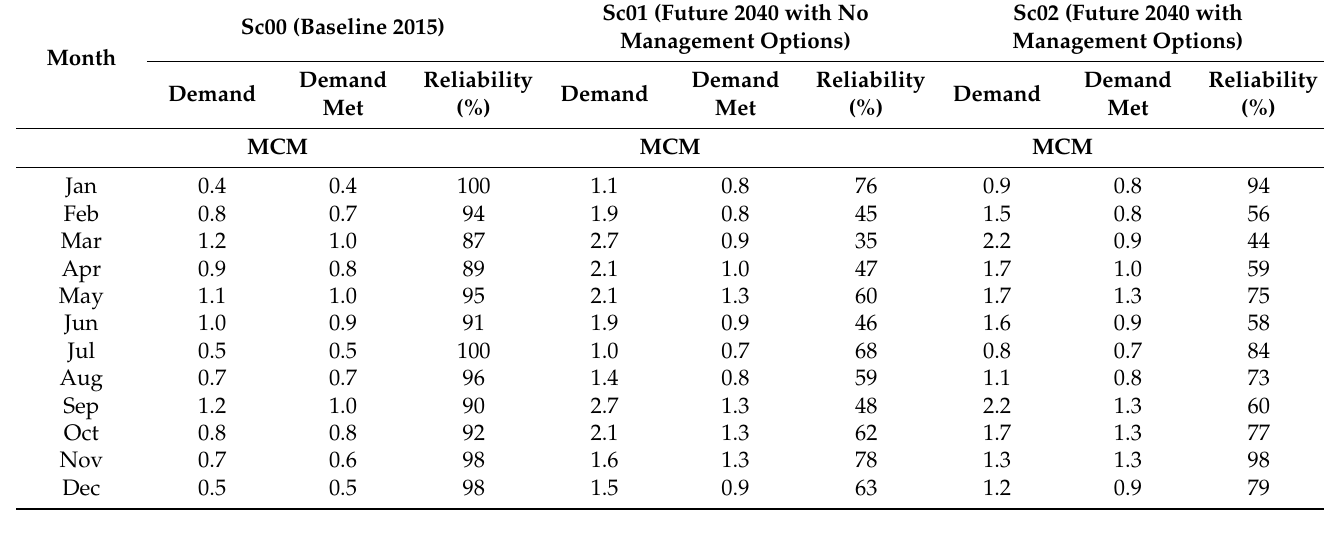
Table 9. Sebwe water use reliability for the three scenarios.